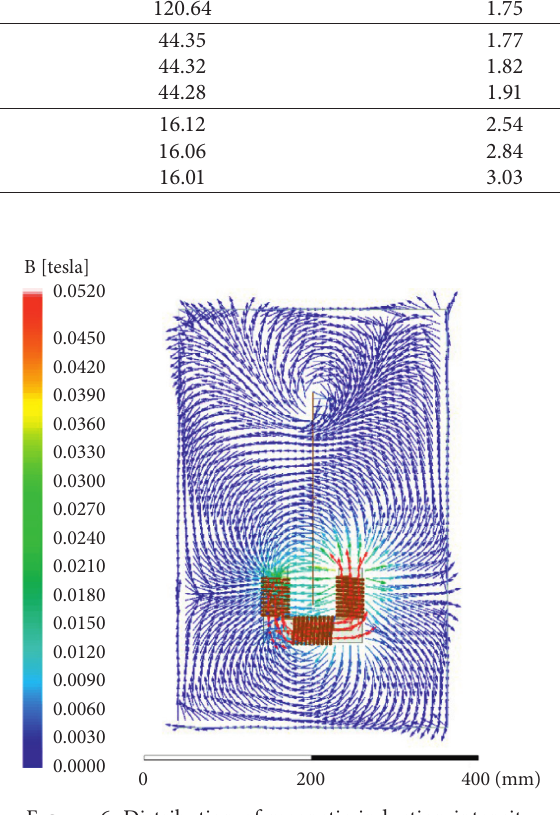
Figure 4: Schematic diagram of relative position between the secondary coil and primary coil. Table 3: Simulation and measured electromagnetic parameters of coupling mechanism under initial standard spacing. Parameter Simulation value/ μ H Experimental values/ μ H Error value (%) L 1